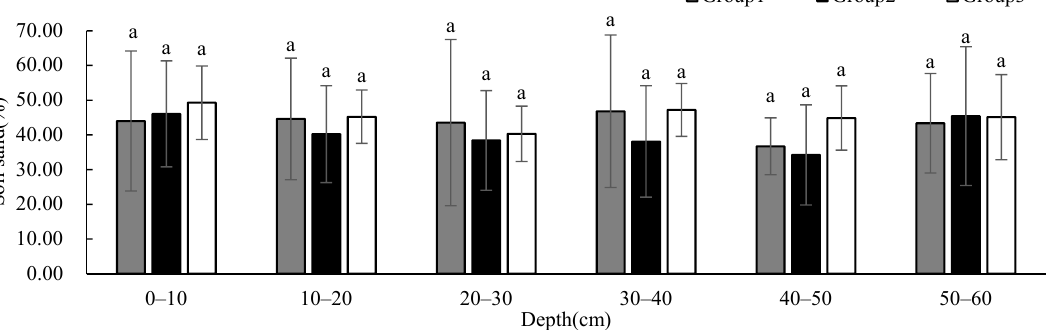
Figure 5. One-way ANOVA results of soil sand contents under different vegetation cover types at different depths ( p < 0.05).